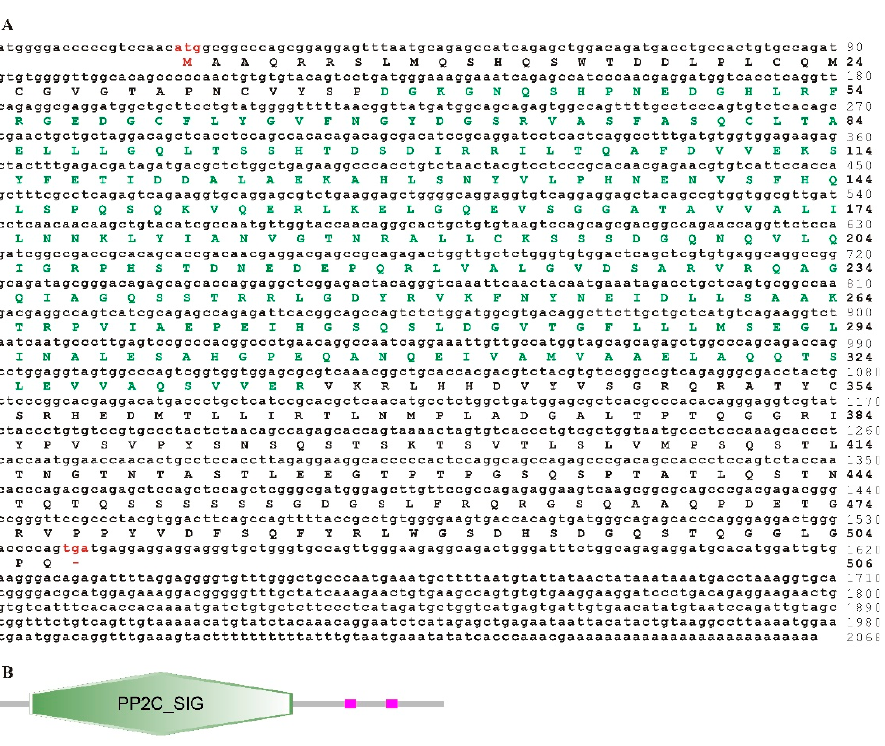
Figure 3. Nucleotide and deduced amino acid sequence of the trTAB1 gene ( A ) and its predicted domains ( B ). The start codon (atg) and stop codon (tga) are marked in red. The PP2C_SIGdomain is marked in green.